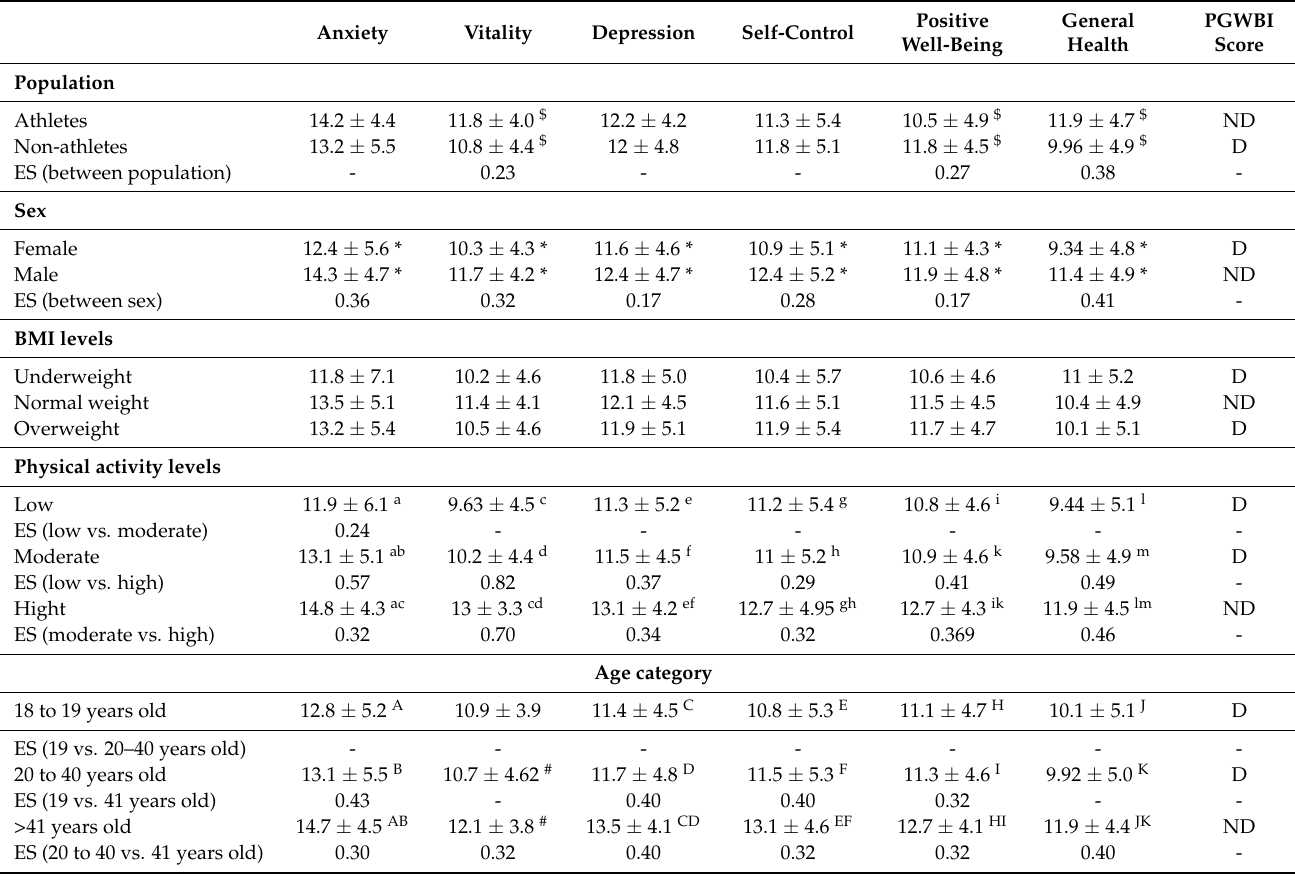
Table 3. The results according to the PGWBI dimensions vs. study variable (population, sex, BMI level, physical activity level, and age category) according to the MANOVA test (Pillai’s Trace).